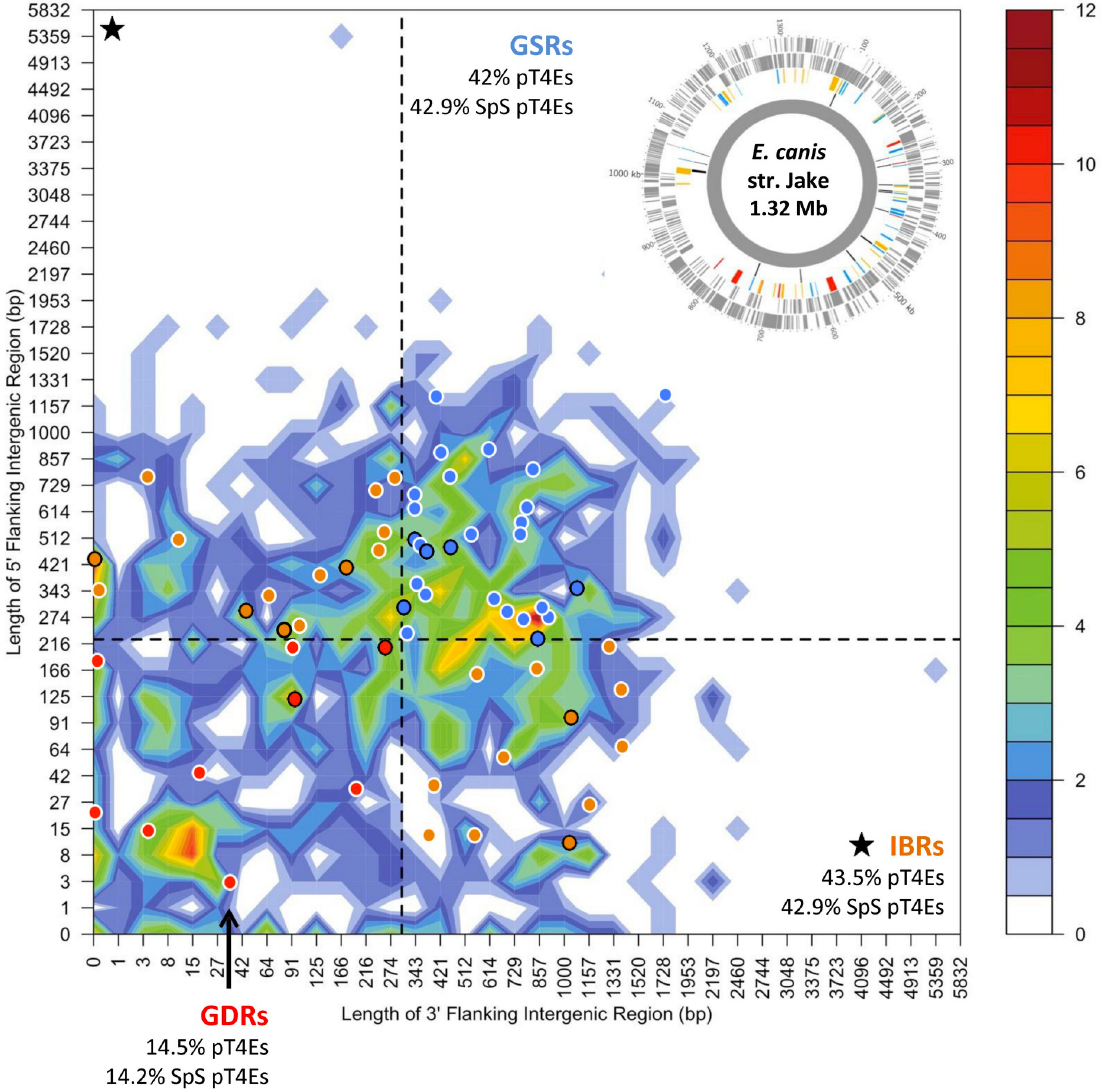
Fig 5. The distribution of Ehrlichia type IV effectomes according to local gene density shows an enrichment of pT4Es in gene sparse regions. Distribution of E . canis str . Jake genes according to the length of their flanking intergenic regions (FIRs). All E . canis genes were sorted in two-dimensional bins according to the length of their 5 0 ( y -axis) and 3 0 ( x -axis) FIRs. The number of genes in the bins is represented by a colour-coded density graph. Genes whose FIRs were both longer than the median length of FIRs were considered as gene- sparse region (GSR) genes. Genes whose FIRs were both below the median value were considered as gene-dense region (GDR) genes. In between region (IBR) genes are genes with a long 5 0 FIR and short 3 0 FIR, and inversely. For E . canis , this median value is 225 bp for 5 0 FIRs and 304 bp for 3 0 FIRs. The dashed line showing the median length of FIR delimits the genes in GSR, GDR and IBR. Candidate effectors predicted using the S4TE 2.0 algorithm were s plotted on this distribution according to their own 3 0 and 5 0 FIRs. A colour was assigned to each of the three following groups: red to GDRs, orange to IBRs, and blue to GSRs. Specific pT4Es are represented by a dot circled in black. In the top right corner, a Circos graph shows the distribution of E . canis str. Jake putative effectors along the genome. The outermost and second circles (in grey) represent E . canis antisense and sense genes, respectively. The third and innermost circles represent pT4Es. The black, red, orange and blue colour of each putative T4 effector corresponds to species-specific effectors located in GDRs, IBRs and GSRs,